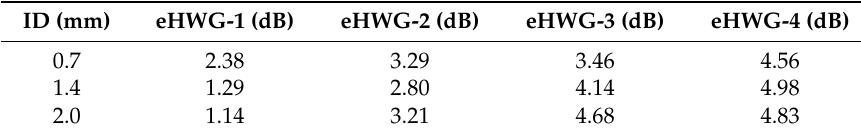
Figure 5. Spectra loss of the eHWGs at the wavelength of 3.31 μ m. Table 1. Spectra losses of the waveguide with different IDs (length = 50 cm).